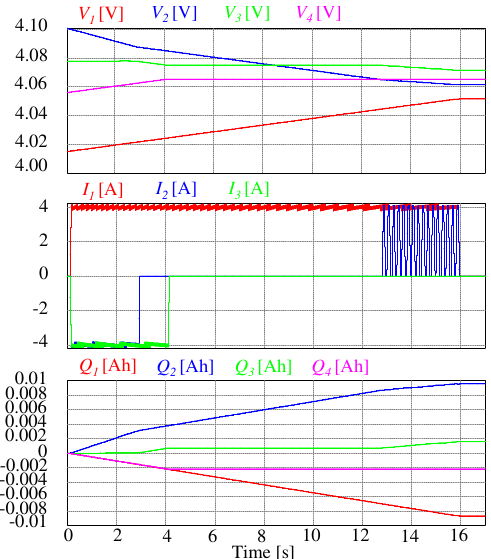
Figure 21. Equalization of a four-cell battery bank using the switched inductor scheme.